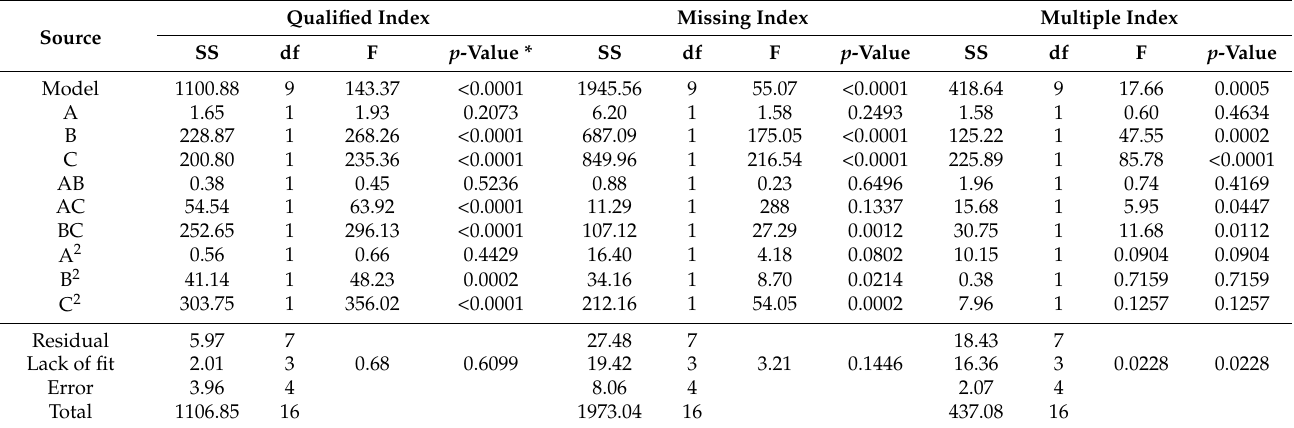
Table 3. Analysis of